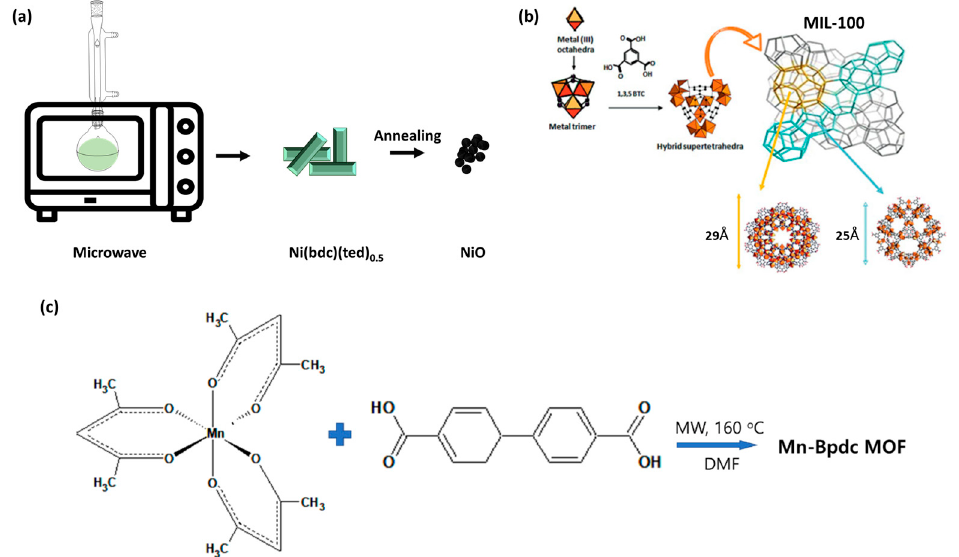
Figure 3. ( a ) MW-assisted synthesis of NiO nanoparticles, ( b ) the formation of thin films by MIL-100, and ( c ) Mn-MOF [79].